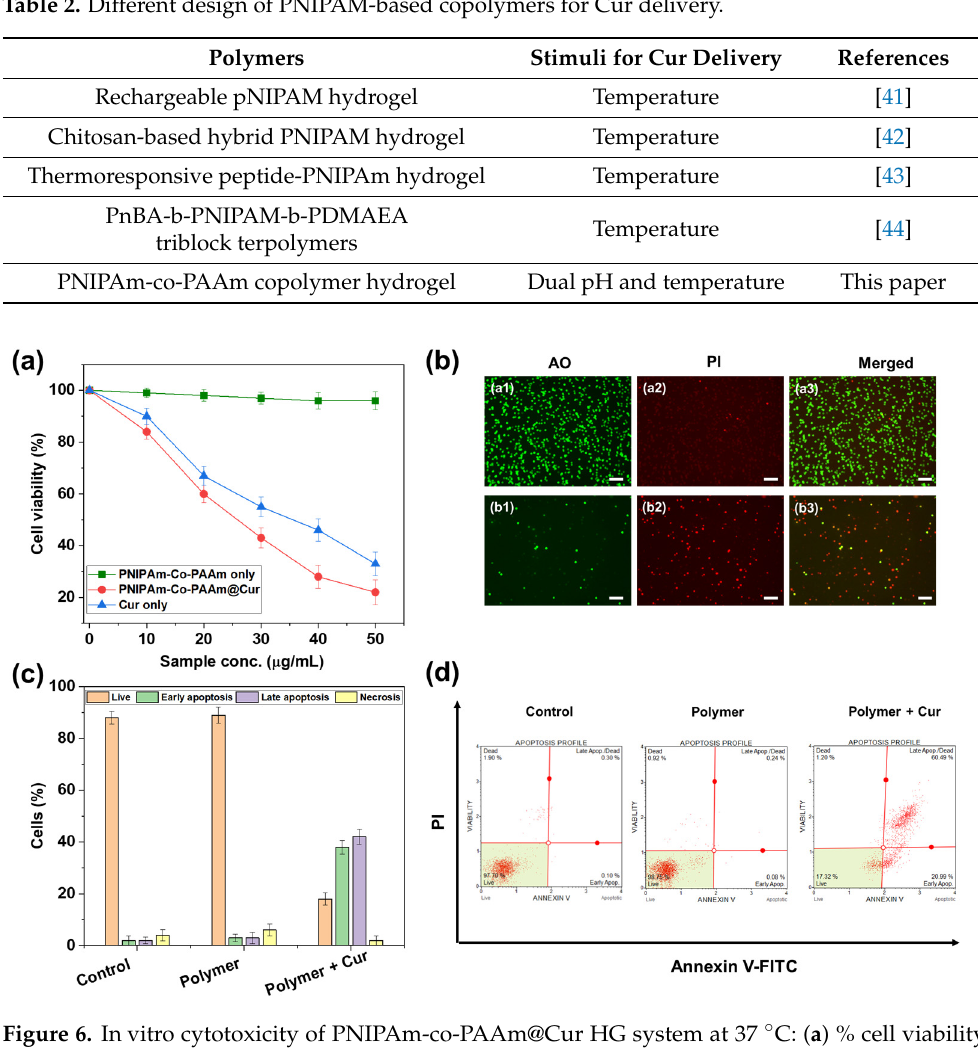
Figure 6. In vitro cytotoxicity of PNIPAm-co-PAAm@Cur HG system at 37 °C: ( a ) % cell viability. ( b ) Fluorescence microscopic images represent in vitro cytotoxicity of PNIPAm-co-PAAm@Cur HG. ( c ) and ( d ) demonstrate flow cytometry (FACS) analysis of PNIPAm-co-PAAm@Cur HG sample at 37